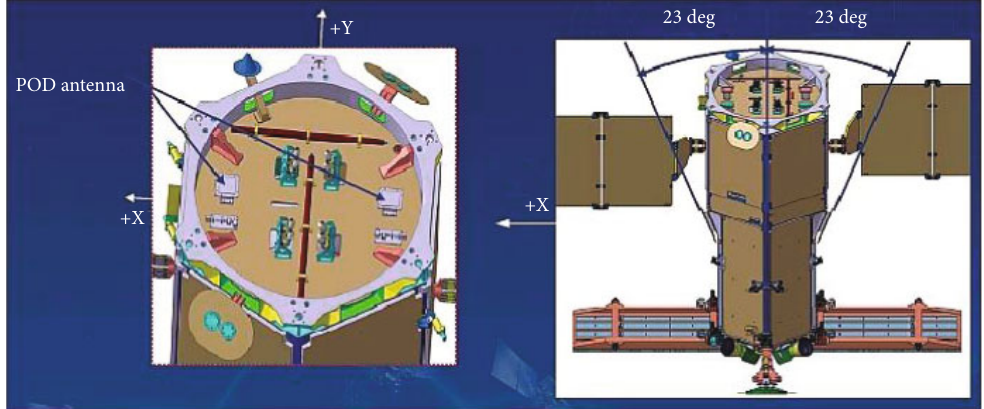
Figure 2: GPS antenna con fi guration for KOMPSAT-5 [10].